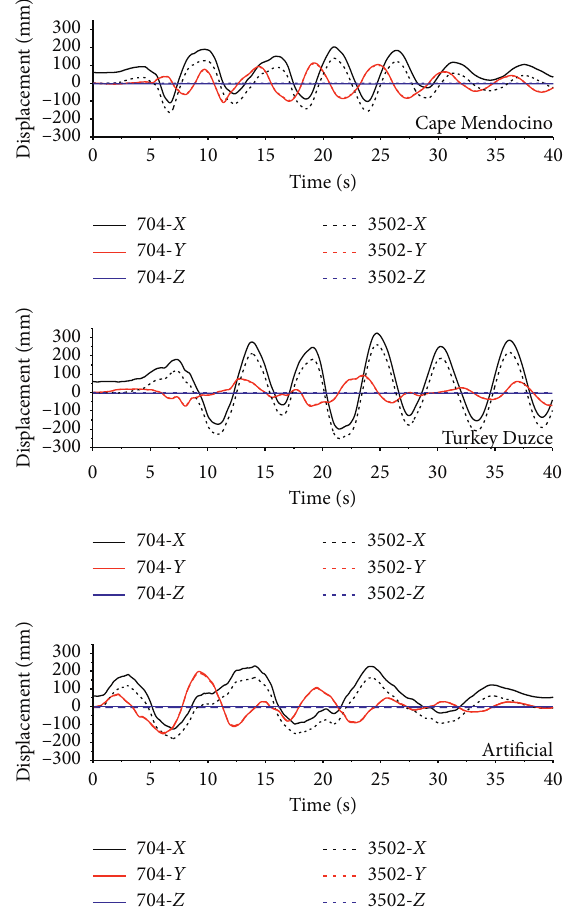
Figure 15: Displacement–time curves of climbing formwork with core tube under the climbing condition.